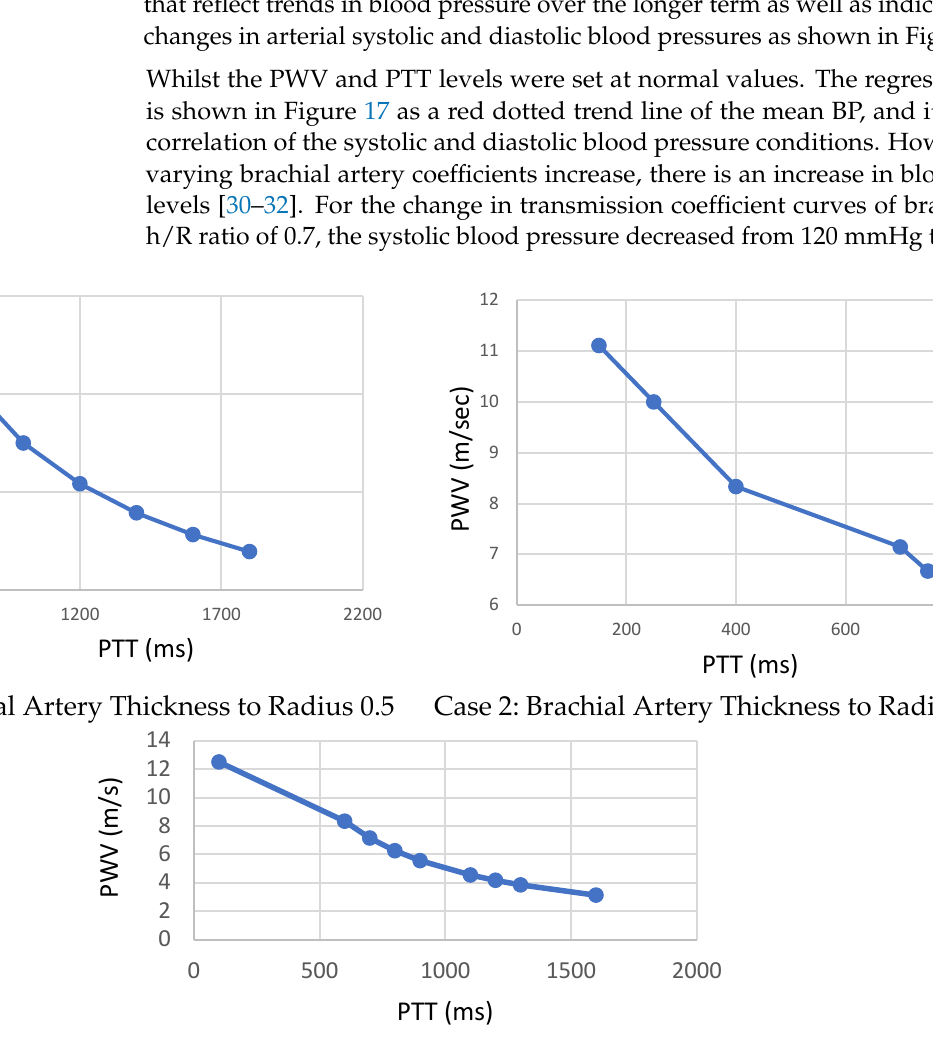
Figure 16. Simulation results of PTT-based pulse measurement dual sensors: Through this variation, PTT estimates for human artery of thickness/radius ratio h/R = 0.5, 0.7 and 0.9. Pulse transit times are extracted and then PWV can be calculated to provide a comprehensive overview of the blood pressure variation level.